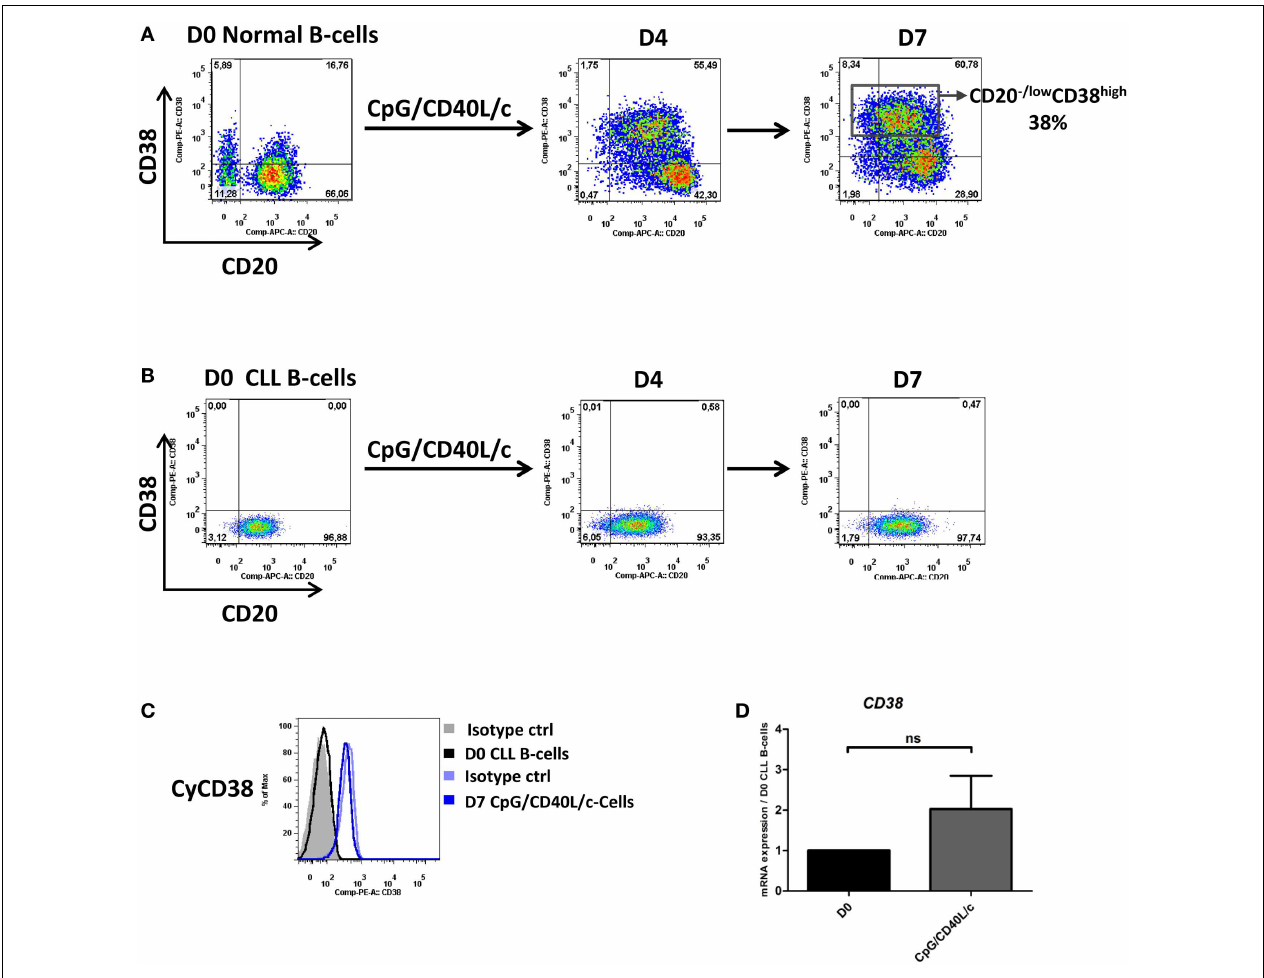
FIGURE 1 | CD20 and CD38 expression on normal and CLL B-cells . Cells were stimulated with CpG, CD40L, and the cytokines IL-2, IL-10, and IL-15. On day 4 (D4), cells were harvested and incubated with IL-2, IL-6, IL-10, and IL-15 for 3days. (A,B) Cells were labeled with anti-CD20 and anti-CD38 mAbs to examine changes in surface expression on normal B-cells (A) and CLL B-cells (B) on D0, D4, and D7. Cytometry plots are representative of two and nine independent experiments for normal B-cells and CLL B-cells, respectively.